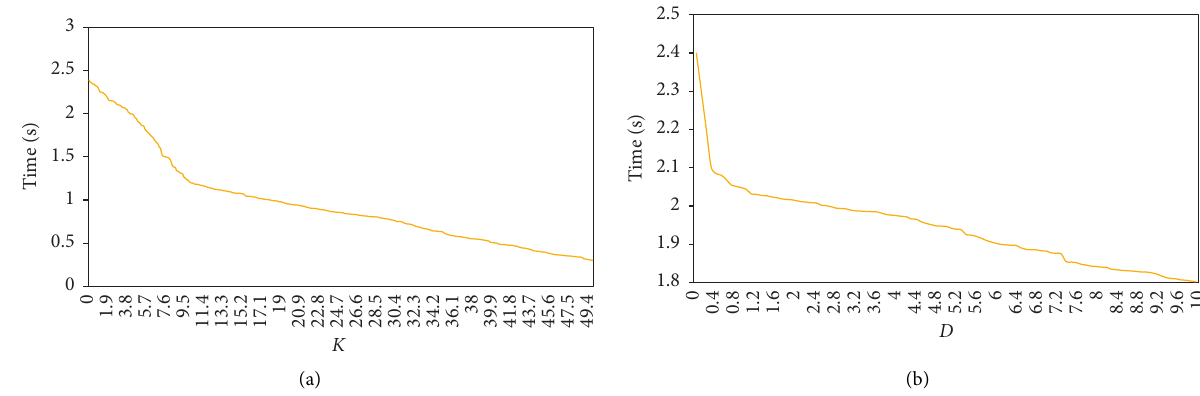
Figure 10: The influence of K and D parameters on Internet of Health Things system adjustment time. (a) K parameter; (b) D parameter.